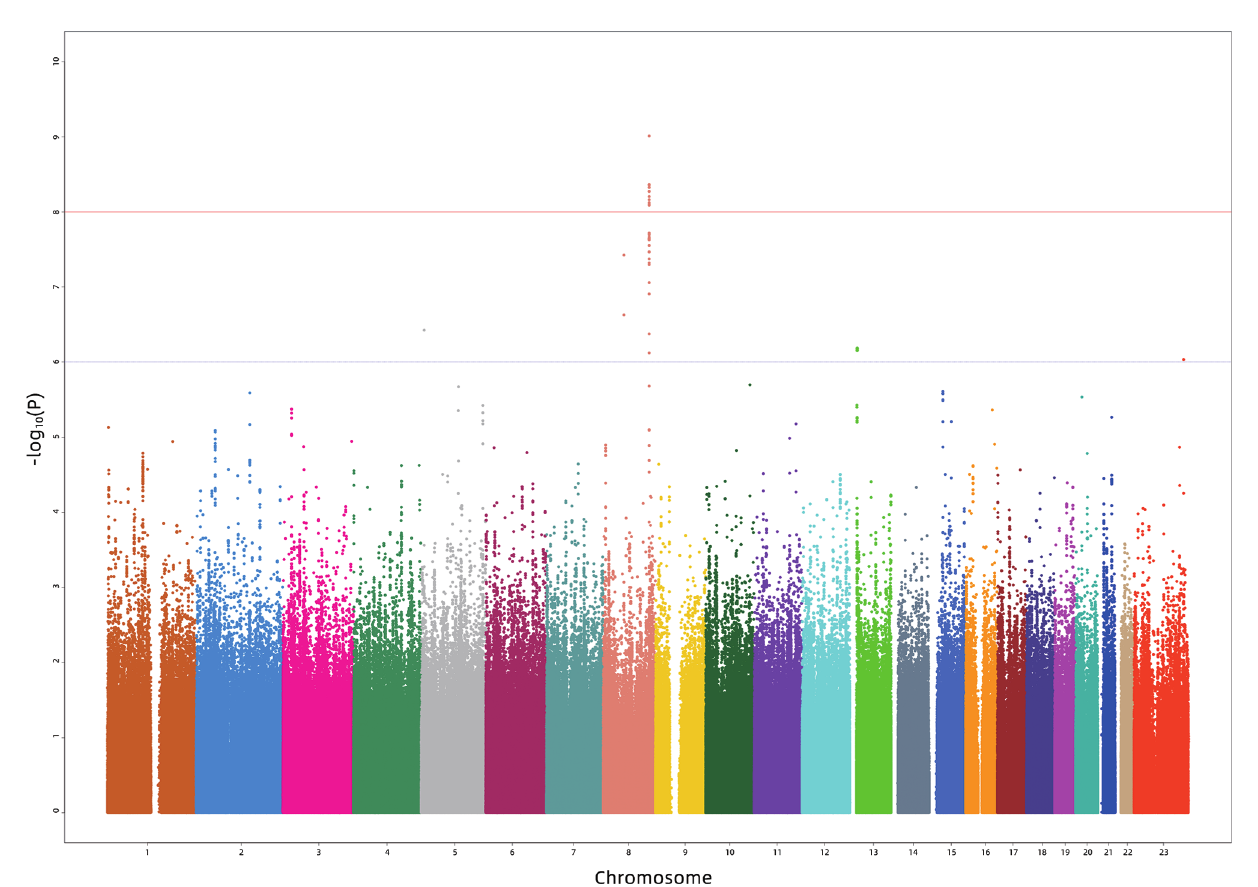
FIGURE 1 | Manhattan plot for the genome-wide association study results for the levels of p2PSA in the Chinese population. The X -axis represents the chromosomal position and the Y -axis represents the – log10 p -value from linear regression. The horizontal dashed line shows the preset threshold of p = 1 × 10 − 6 . The horizontal solid line indicates the preset threshold of p = 1 × 10 − 8